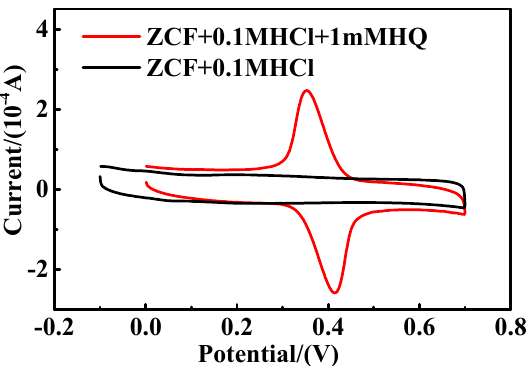
Figure 4. The cyclic voltammetry curves of ZCF/glassy carbon electrode (GCE) in 0.1 M hydrochloric acid electrolyte with and without 1 mM hydroquinone (HQ) (scan rate was 20 mV/s). The CV responses of HQ at three different GCEs (bare GCE, ZCF/GCE, CF/GCE) were examined by cyclic voltammerey in the 0.1 M hydrochloric acid solution containing 1 mM HQ with